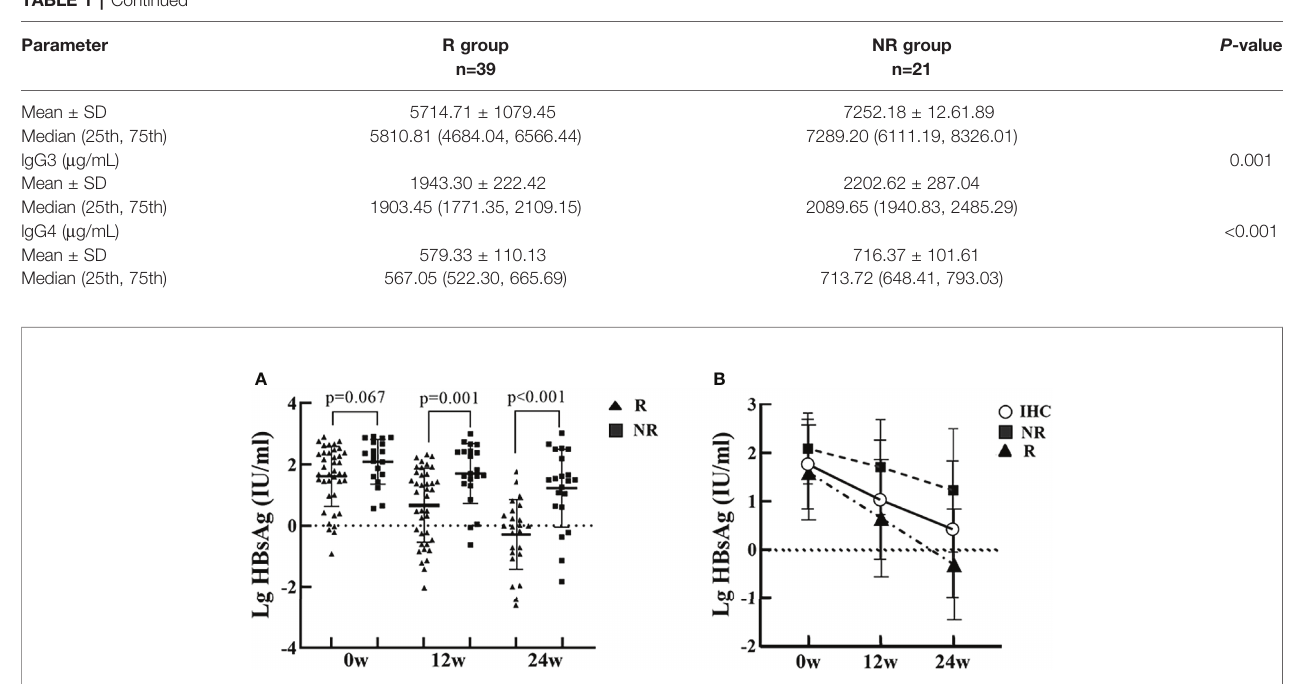
FIGURE 2 | HBsAg at baseline, and at 12 and 24 weeks of PEG-IFN treatment in the R and NR groups. (A) The level of HBsAg in the R group was lower than in the NR group, but were not signi fi cantly different (P=0.067). The levels of HBsAg in the R group was signi fi cantly lower than in the NR group (P=0.001, P<0.001) at 12 and 24 weeks of treatment. (B) HBsAg showed a signi fi cant downward trend after PEG-IFN treatment in IHCs, with HBsAg quanti fi cation at 12 and 24 weeks signi fi cantly lower than baseline, especially in the R group.